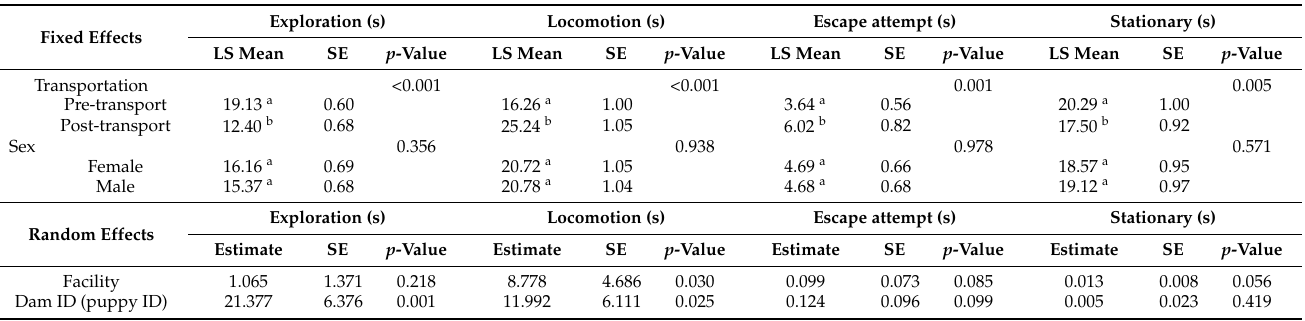
Table 3. Effect of transportation, sex, facility, and Dam ID on the duration (sec.) of exploration, locomotion, escape attempt, and stationary behaviors exhibited by puppies during the isolation test ( n =